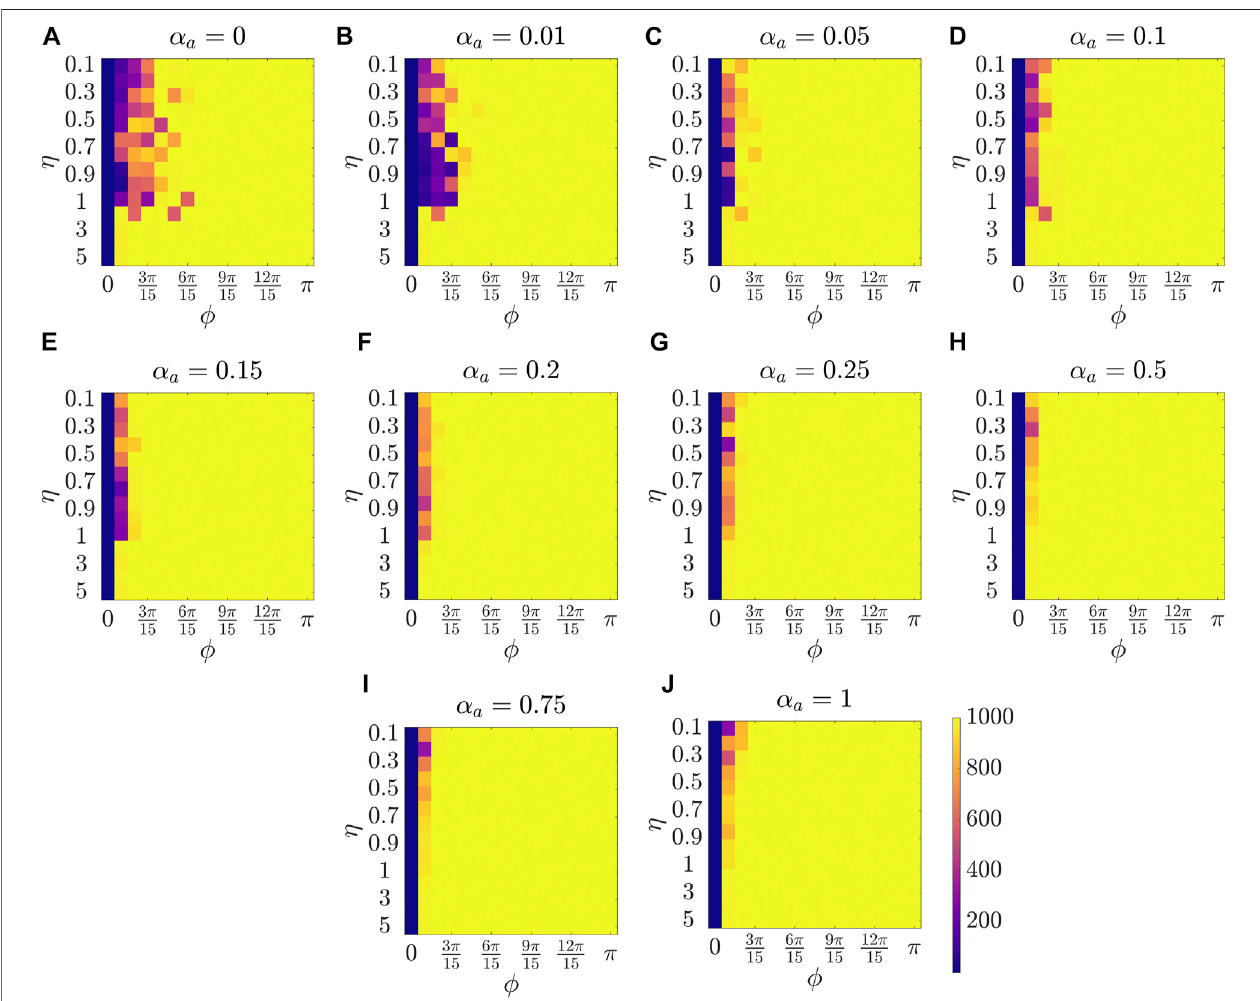
FIGURE4| Resultsforthemeanlargestclustersizeatdifferentvaluesof α a ,shownatthetitleofeachsub- fi gure.Withineachsub- fi gure (A – J) , η isvariedalongthe vertical axis, and ϕ is varied along the horizontal axis.